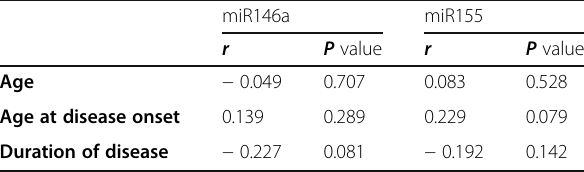
Table 7 Correlation between miR146a/miR155 and the age of BD patients, age at disease onset, and duration of BD